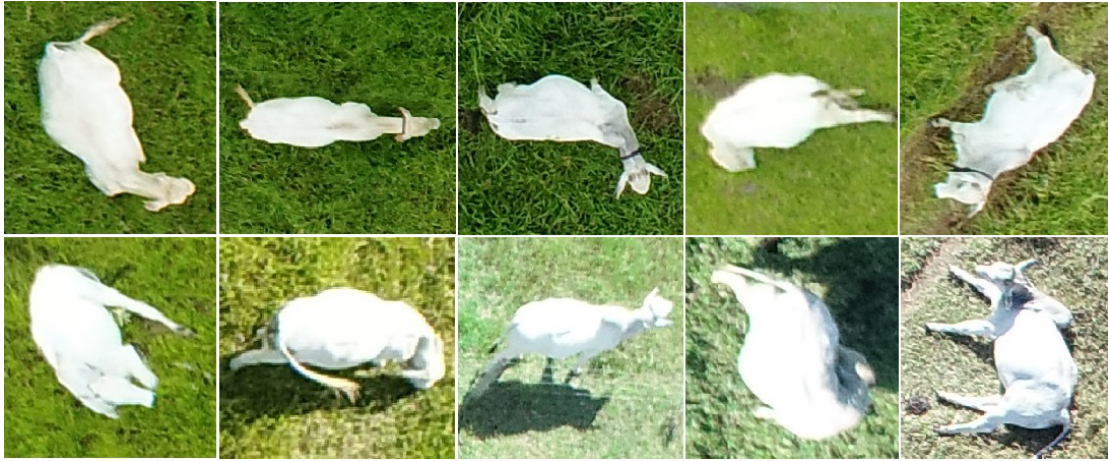
Figure 7. Examples of animals in different